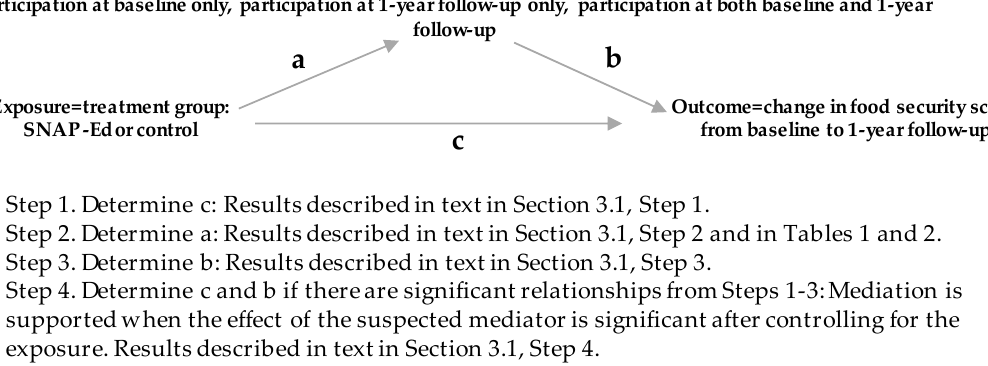
Figure 1. Hypothesized Baron-Kenny causal mediation model of the Supplemental Nutrition Assistance Program-Education (SNAP-Ed) intervention e ff ect by the “change in one year participation status” in Supplemental Nutrition Assistance Program (SNAP), Women, Infants, and Children (WIC), or food pantries on the change in one year food security score among Indiana SNAP-Ed Study participants. a = the relationship of the exposure on the suspected mediator using regression, b = the relationship of the suspected mediator on the outcome using regression, c = the relationship of the exposure on the outcome using regression.